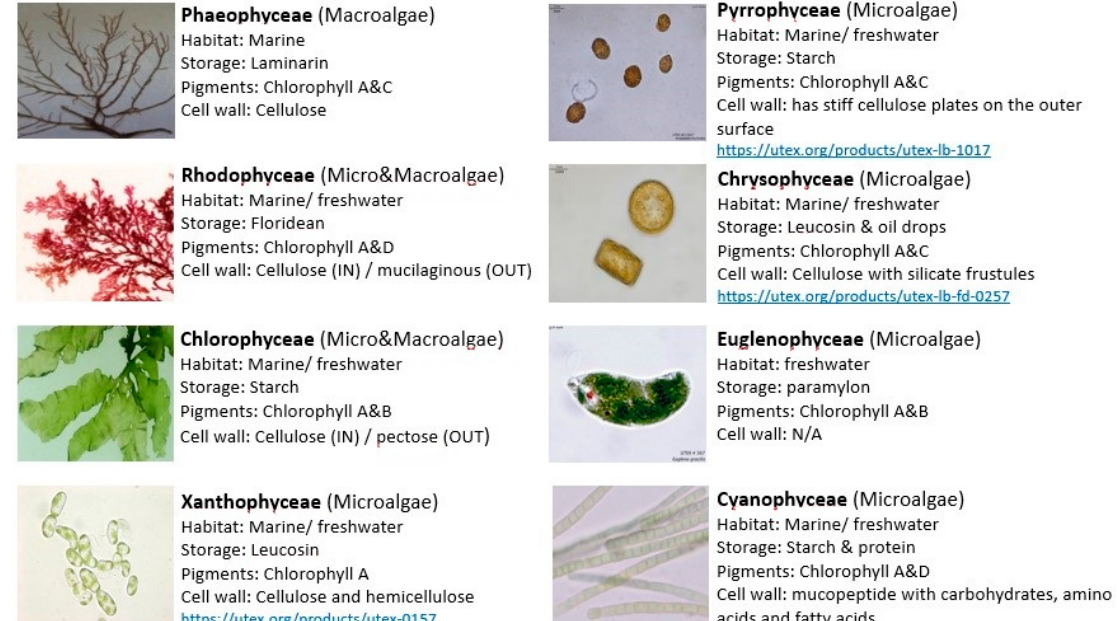
Figure 2. Different groups of algae. Various options are available for algae type and strain choice. They di ff er in shapes from a single cell to multicellular structures like filaments and